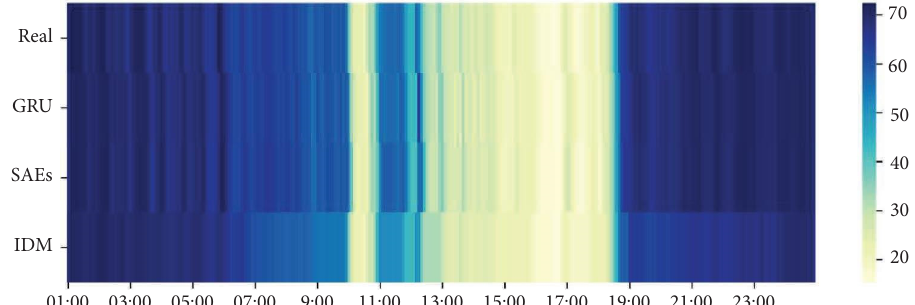
Figure 5: Speed distribution for diferent models by time of